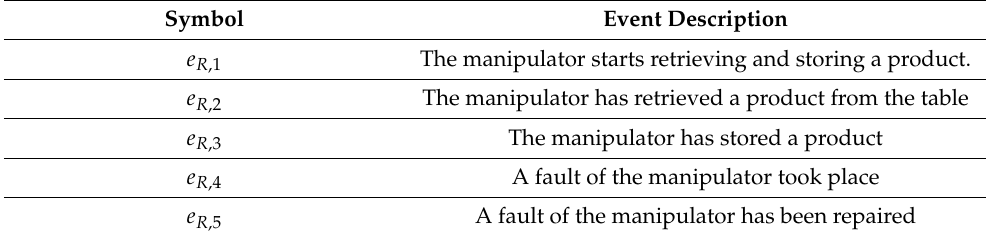
Table 10. Events of the robotic